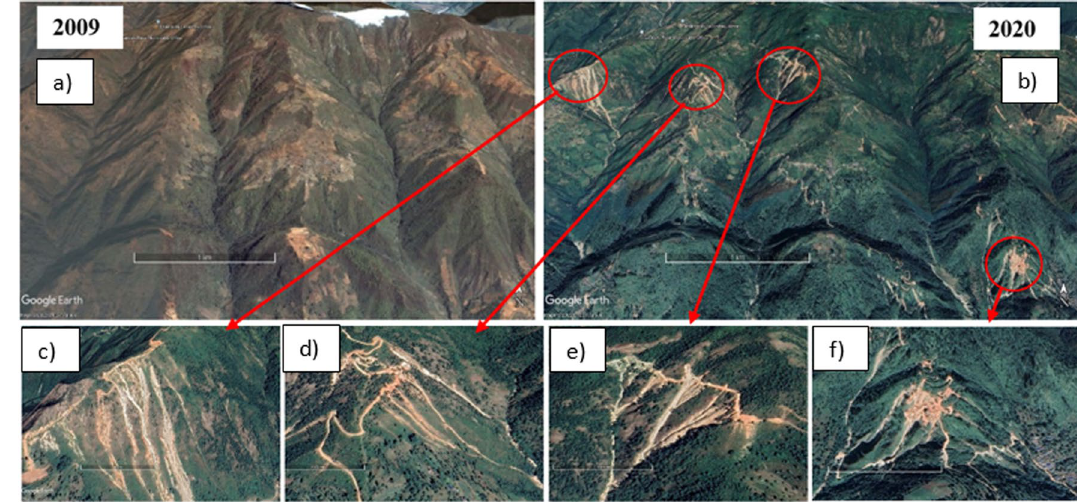
Fig. 1 A rural hillslope in Kurintar, Nepal in 2009 ( a ) and 2020 ( b ). Four large landslides ( c – f outlined in red) occurred here as a direct consequence of the construction of a rural